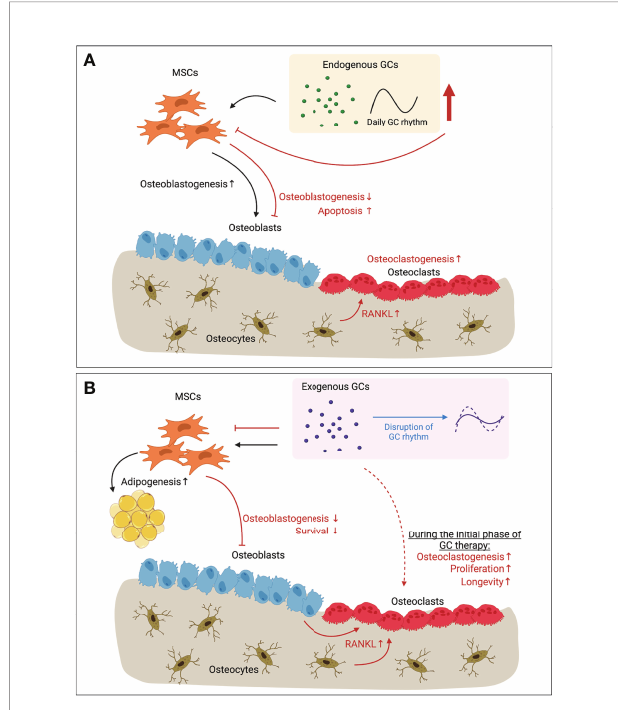
FIGURE 1 | Paradoxical effects of GCs in bone. (A) Endogenous GCs regulated by circadian rhythm (and expressing daily GC rhythm accordingly) have anabolic effects on osteoblastogenesis (black arrows). When endogenous GC level is increased upon stress (e.g. mechanical unloading), however, bone mass is decreased due to inhibited osteoblastogenesis, increased apoptosis of osteoblasts and osteocytes, and enhanced osteoclastogenesis due to the increased RANKL secreted by apoptotic osteocytes (red arrows). (B) Long-term exogenous GC therapy inhibits osteoblastogenesis and survival of osteoblasts (red arrows). Increased RANKL secretion by osteoblasts and osteocytes let enhance bone resorption by osteoclasts (red arrows). Direct action of exogenous GCs on osteoclasts has showed with increased osteoclastogenesis, increased proliferation and longevity of osteoclasts during the initial phase of GC therapy (dotted red arrow). However, direct effects of long-term GC therapy on osteoclasts still remain elusive. Exogenous GCs also regulate the balance between osteoblastogenesis and adipogenesis of MSCs that is one of feature of GIO (black arrows). On the other hand, continuous exogenous GC therapy can fl atten the endogenous GCs rhythm (blue arrow), resulting in disrupted circadian gene expression and levels of circulating bone turnover markers. Together, Long-term GC therapy leads to bone loss by its direct action on bone cells, and/or via disrupting GC rhythm. GC, Glucocorticoid; RANKL, Receptor activator of nuclear factor- k B ligand; MSC, Mesenchymal stem cell; GIO, GC-induced osteoporosis. This illustration was created with